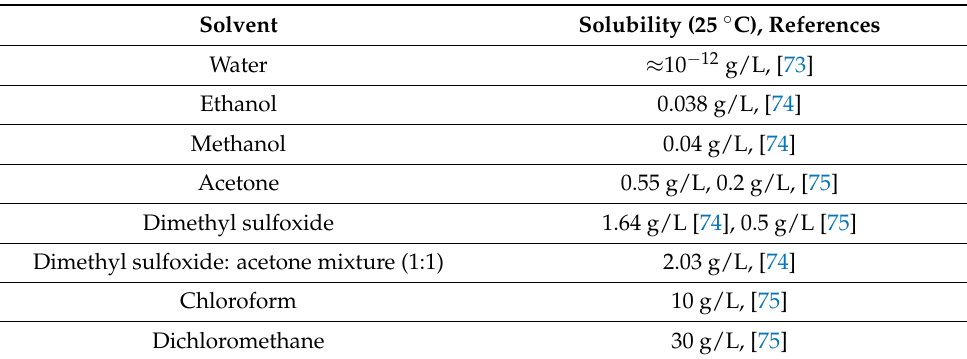
Table 1. Solubility of astaxanthin at room temperature (25 ◦ C) in different organic